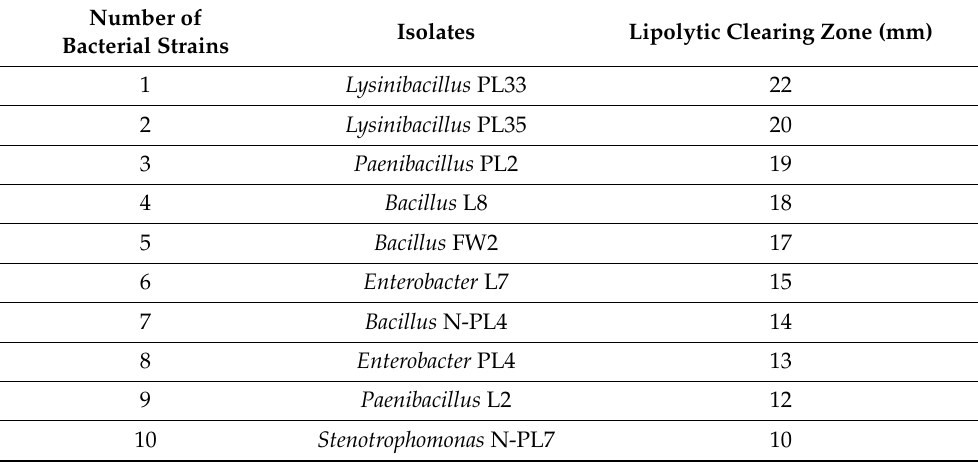
Table 1. Screening of lipolytic activity and lipase production of bacteria isolated from soil using modified culture method.